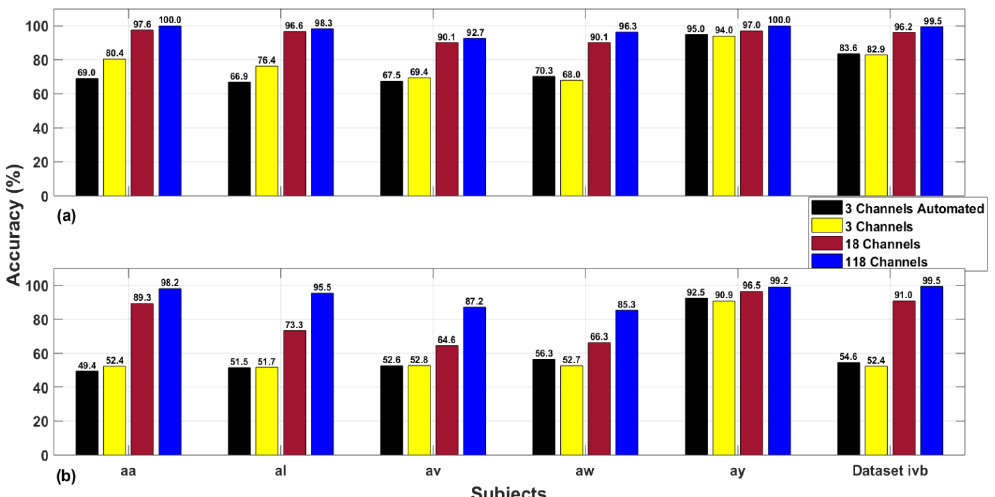
Figure 4. Bar plots for the comparison of 3-channel automated, 3-channel, 18-channel, and 118-channel results: ( a ) FFNN classifier and ( b ) SVM